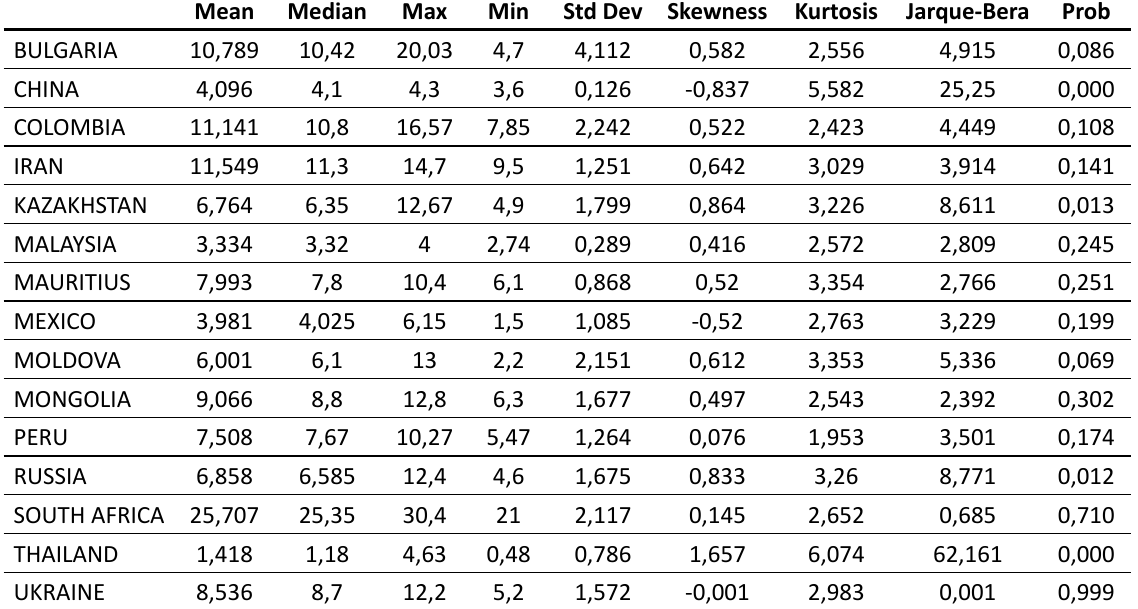
Table 1: Statistical Characteristics of The Unemployment